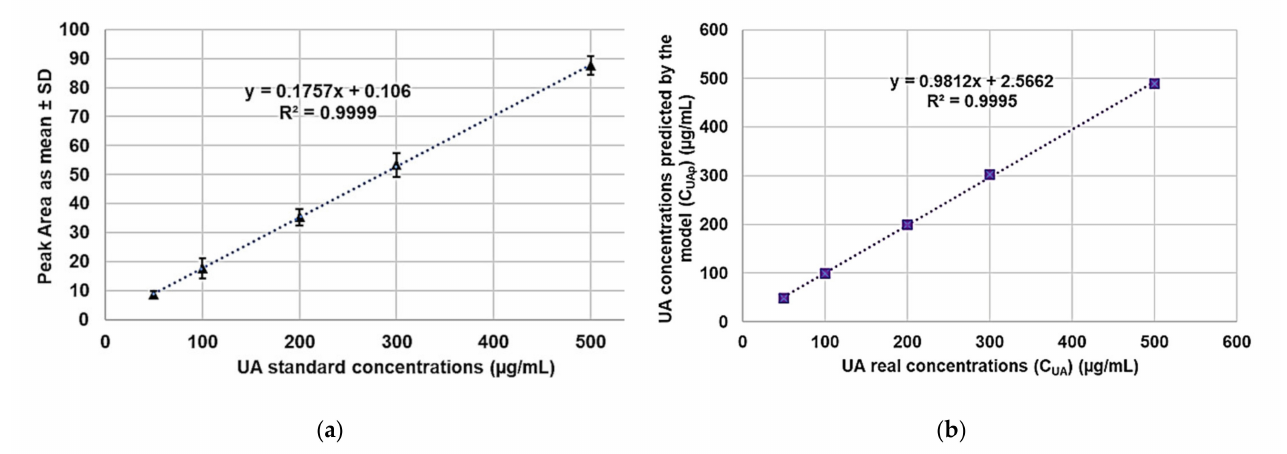
Figure 9. UA linear calibration model ( a ); C UAp vs. C UA ( b ).